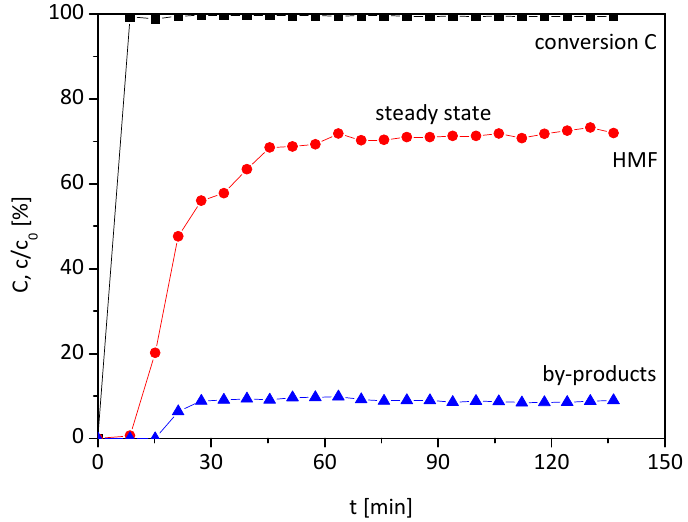
Figure 1. Reaction course in a continuous fixed bed reactor until a steady state was reached (0.1 M fructose, 105 °C, 15 vol% H 2 O in HFIP, residence time τ = 20 min, 1.7 g Lewatit K2420 catalyst bed).